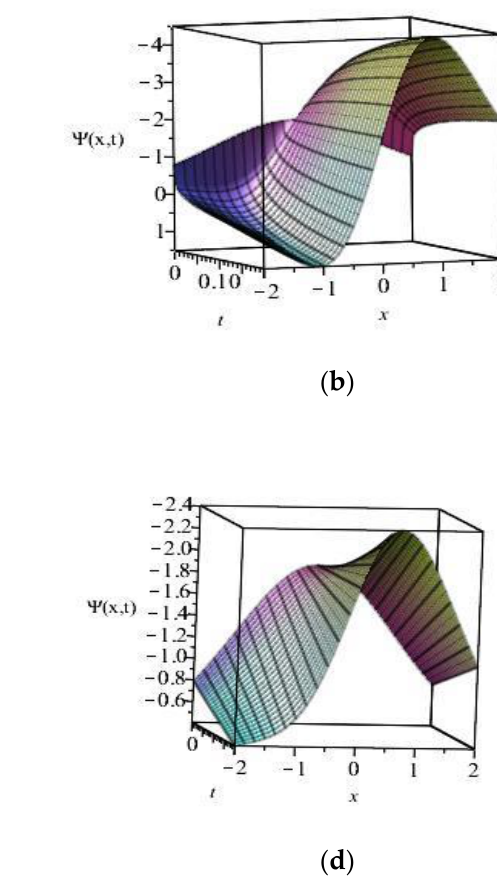
Figure 2. Plots of ψ ( x , t ) with respect to x and t at ( a ) α = 0.5 ( b ) α = 0.25 ( c ) α = 0.75 ( d ) α = 1 for Equation (31).